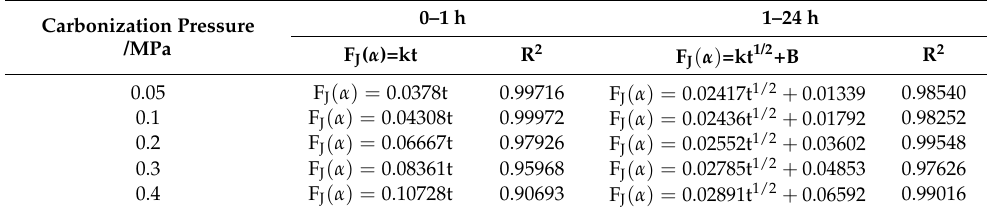
Table 2. Results of the linear-regression analysis under different CO 2